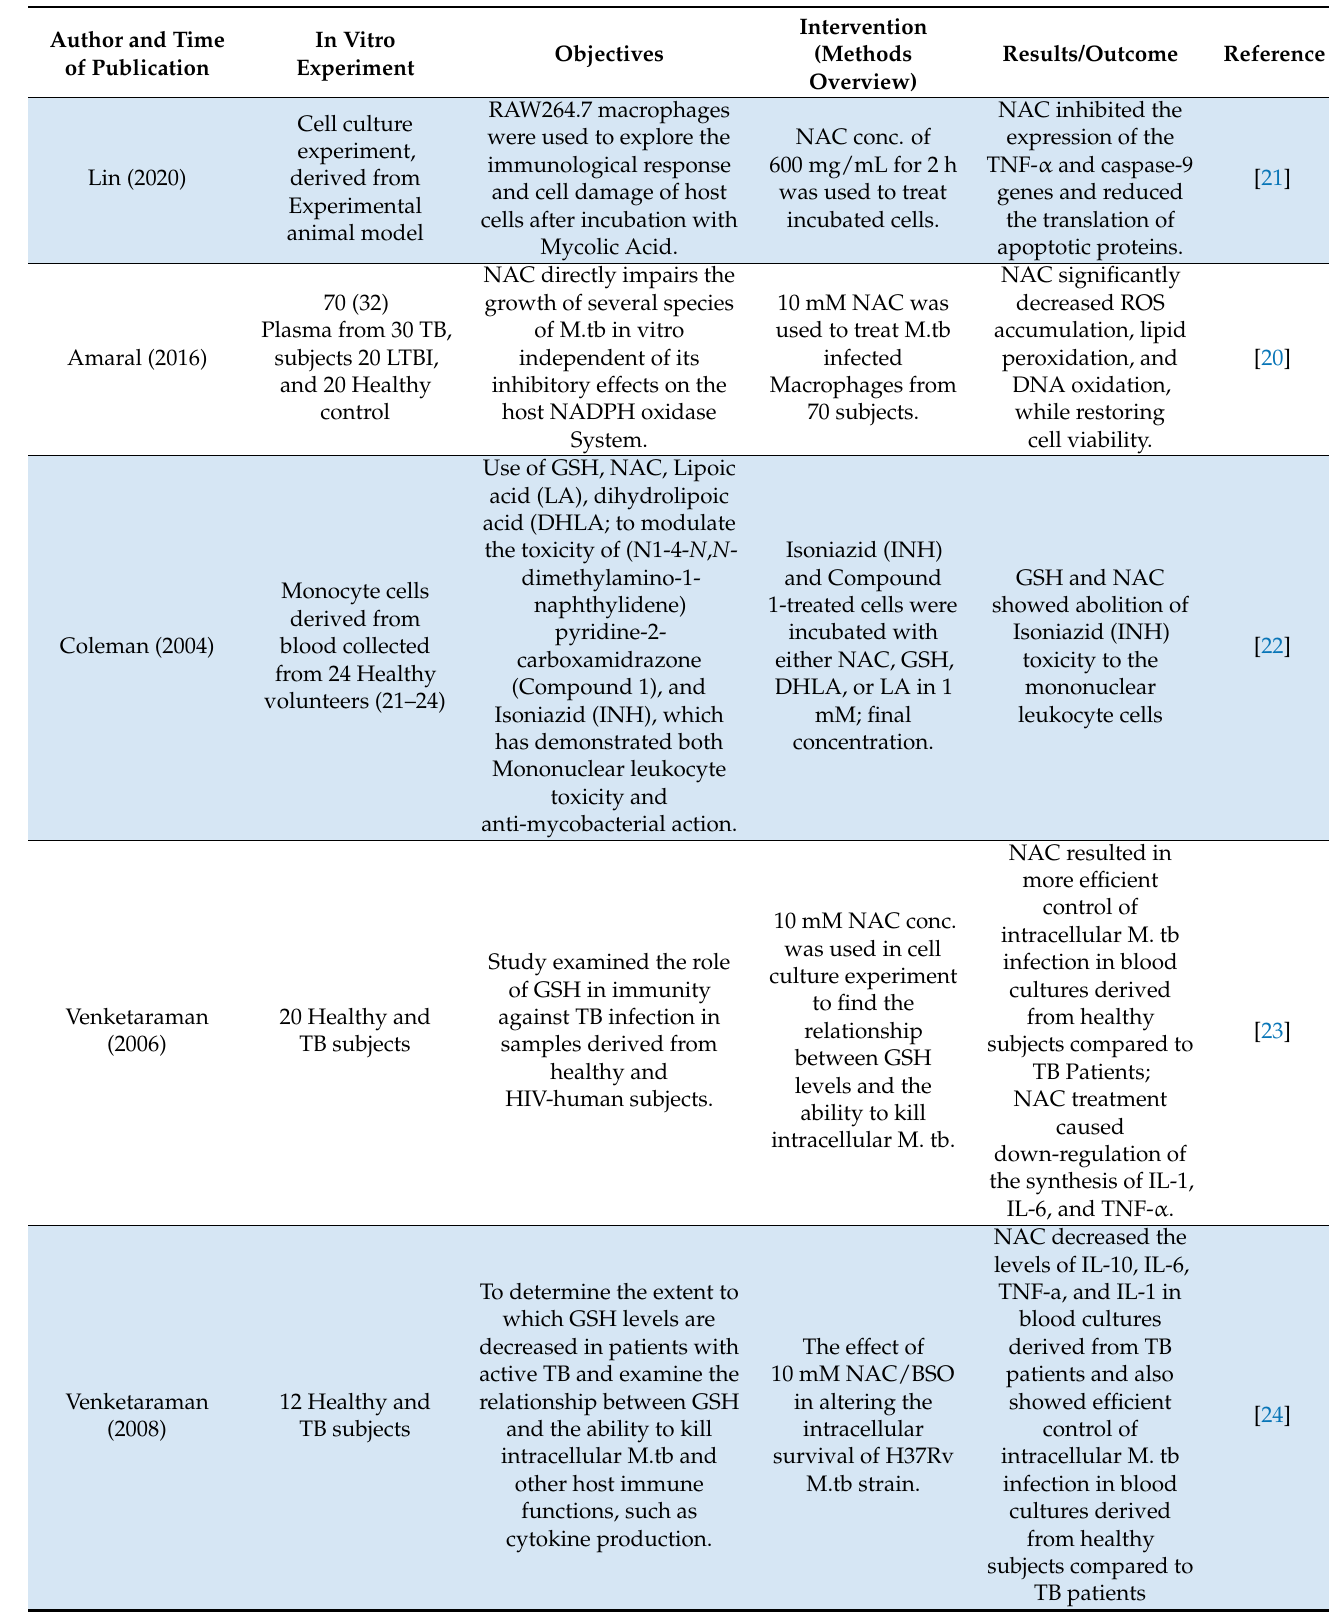
Table 1. In vitro